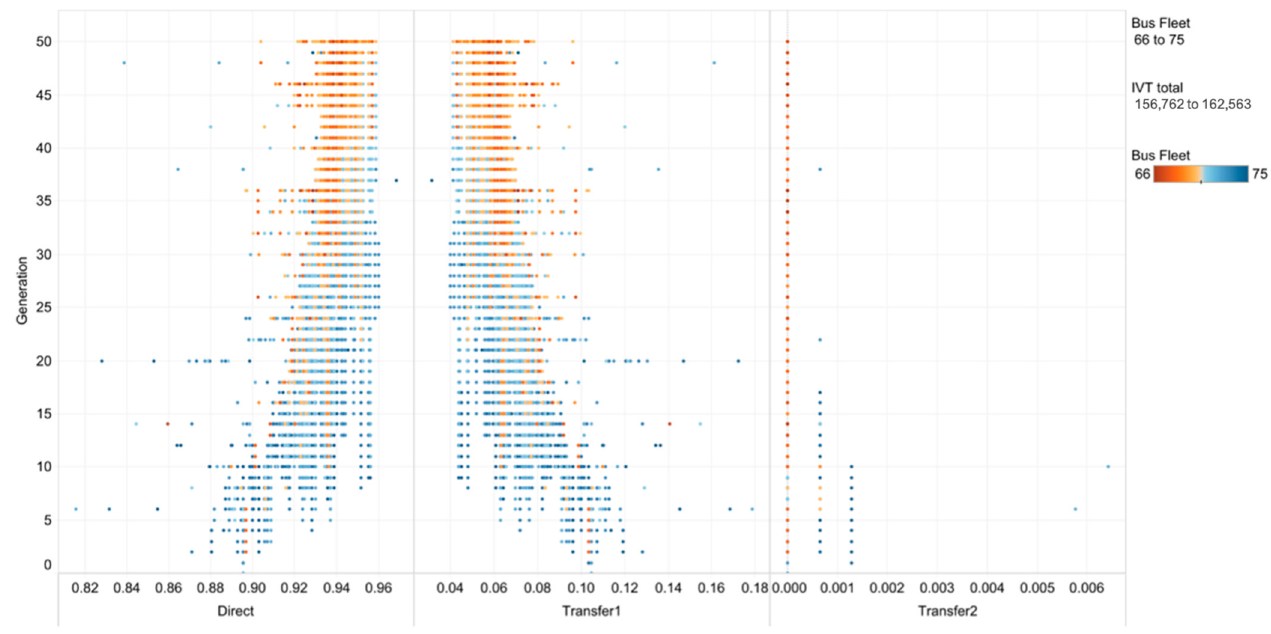
Figure 4. Direct, 1-transfer and 2-transfer percentages per chromosome per generation (color signifies bus fleet size).